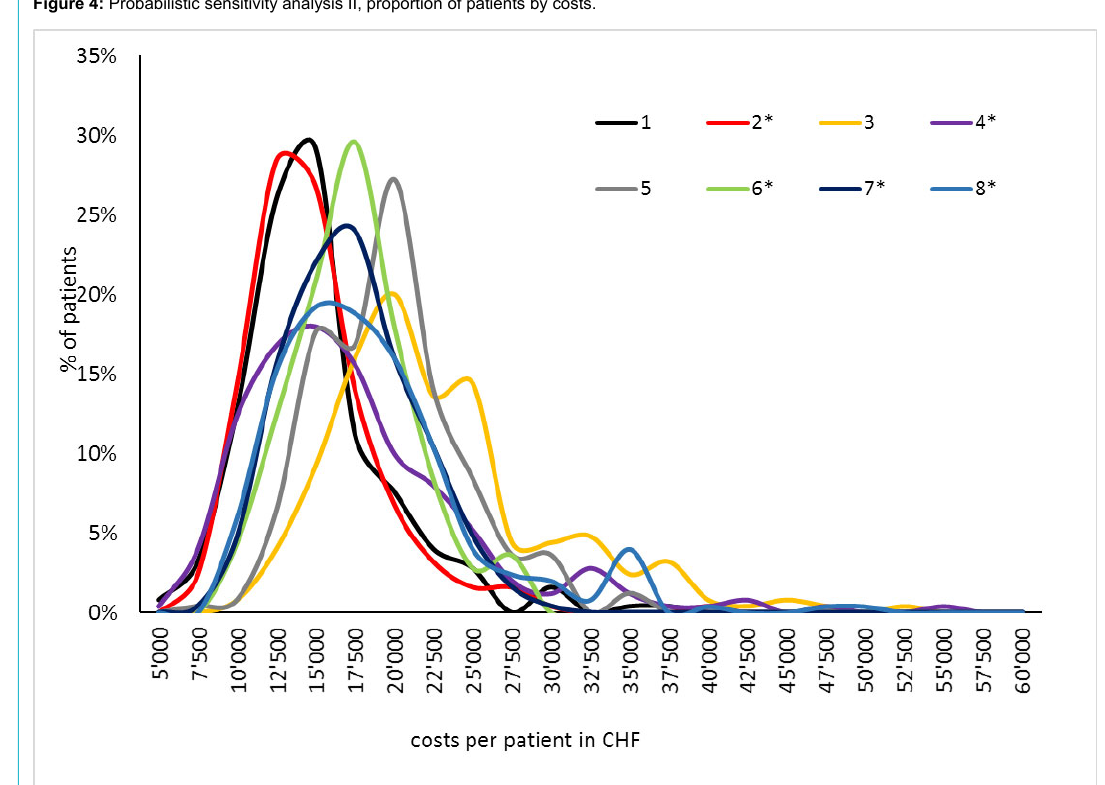
Figure 4: Probabilistic sensitivity analysis II, proportion of patients by